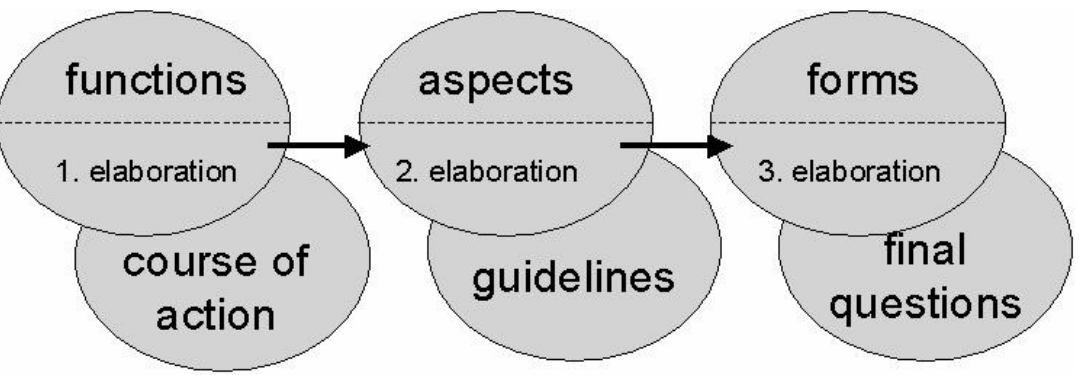
Figure 1. Six-phased feedback model (6P/ FB) for designing feedback in blended